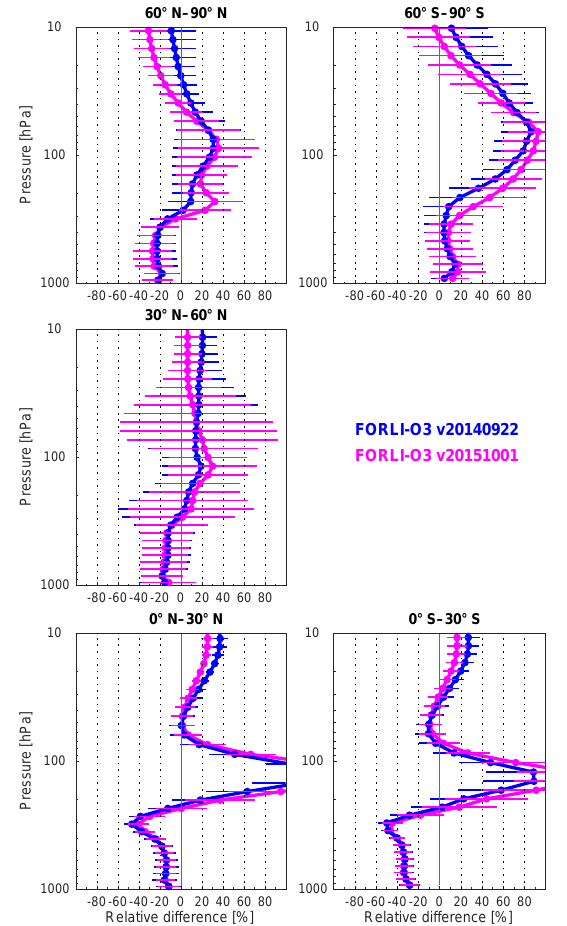
Figure 21. Mean relative differences in percent between FORLI- O3 v20140922 (blue) and FORLI-O3 v20151001 (magenta) against sonde ozone vertical profiles for six 30 ◦ latitude bands. The stan- dard deviation profiles are also shown. The relative difference is calculated as 100 × (FORLI-O3 − ozonesonde) /